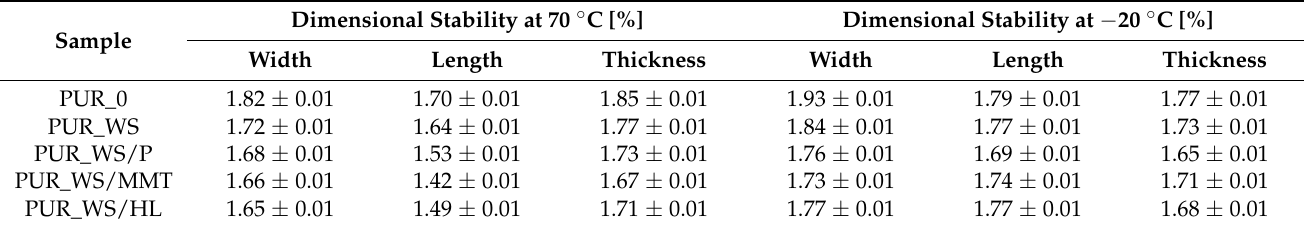
Table 2. Dimensional stability of PUR composites containing walnut shell fillers.